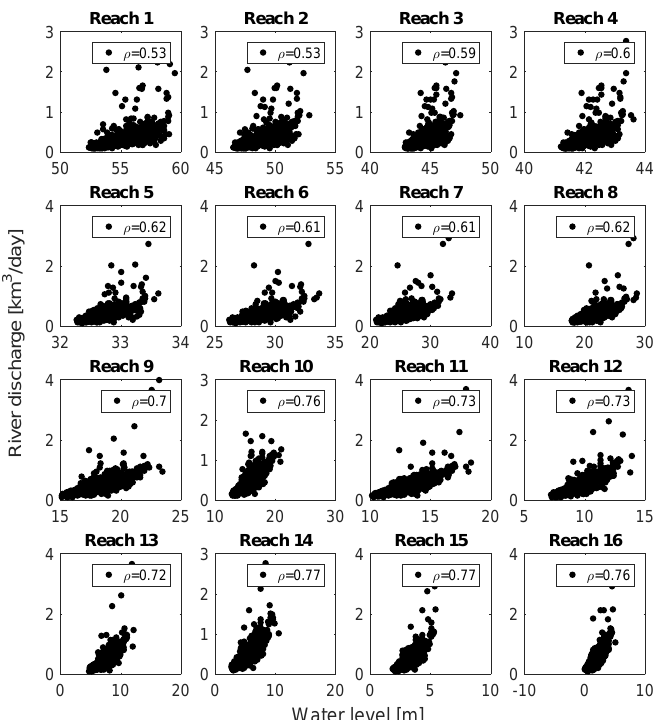
Figure A1. Comparison of water level time series and discharge at nearby gauging stations for 16 reaches along the Po River.